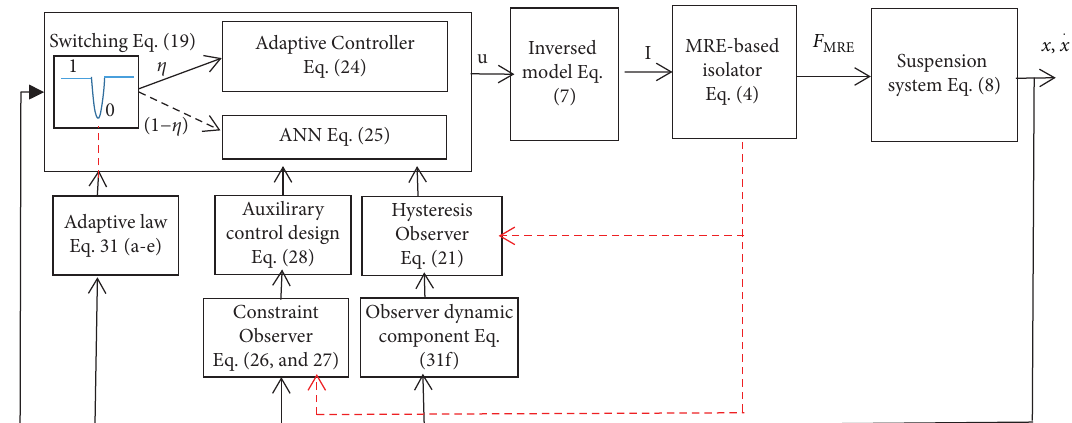
Figure 8: Block diagram of the proposed